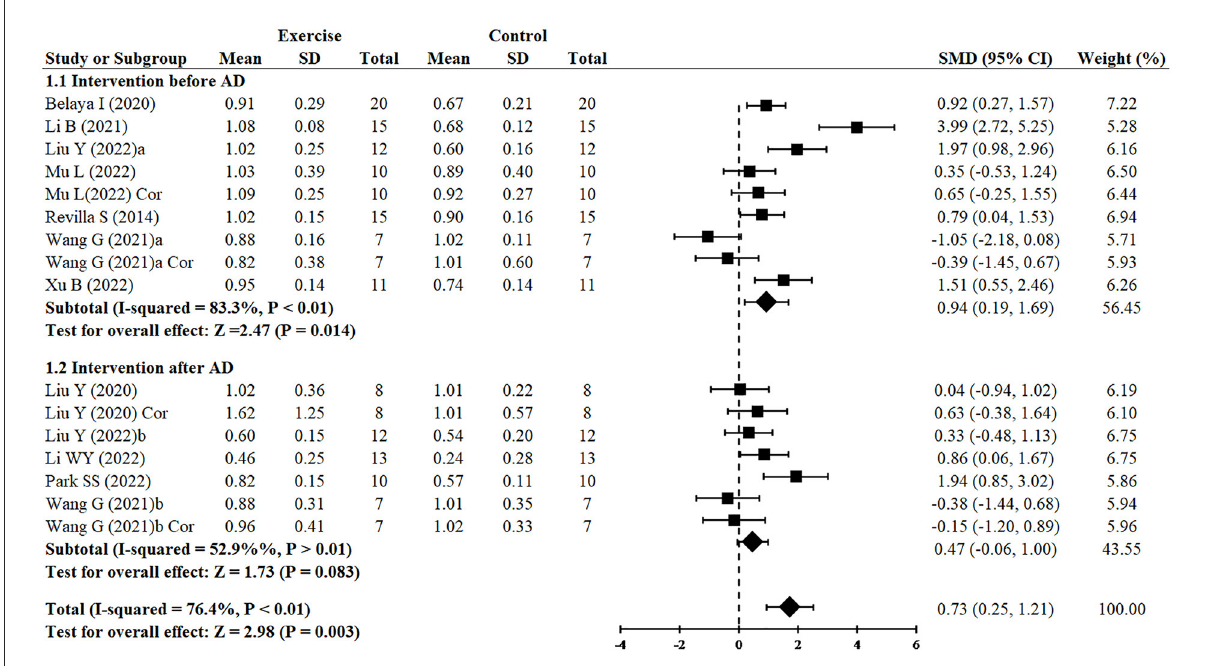
FIGURE3 Forest plot showing the effect of exercise on the expression of PSD95 in AD